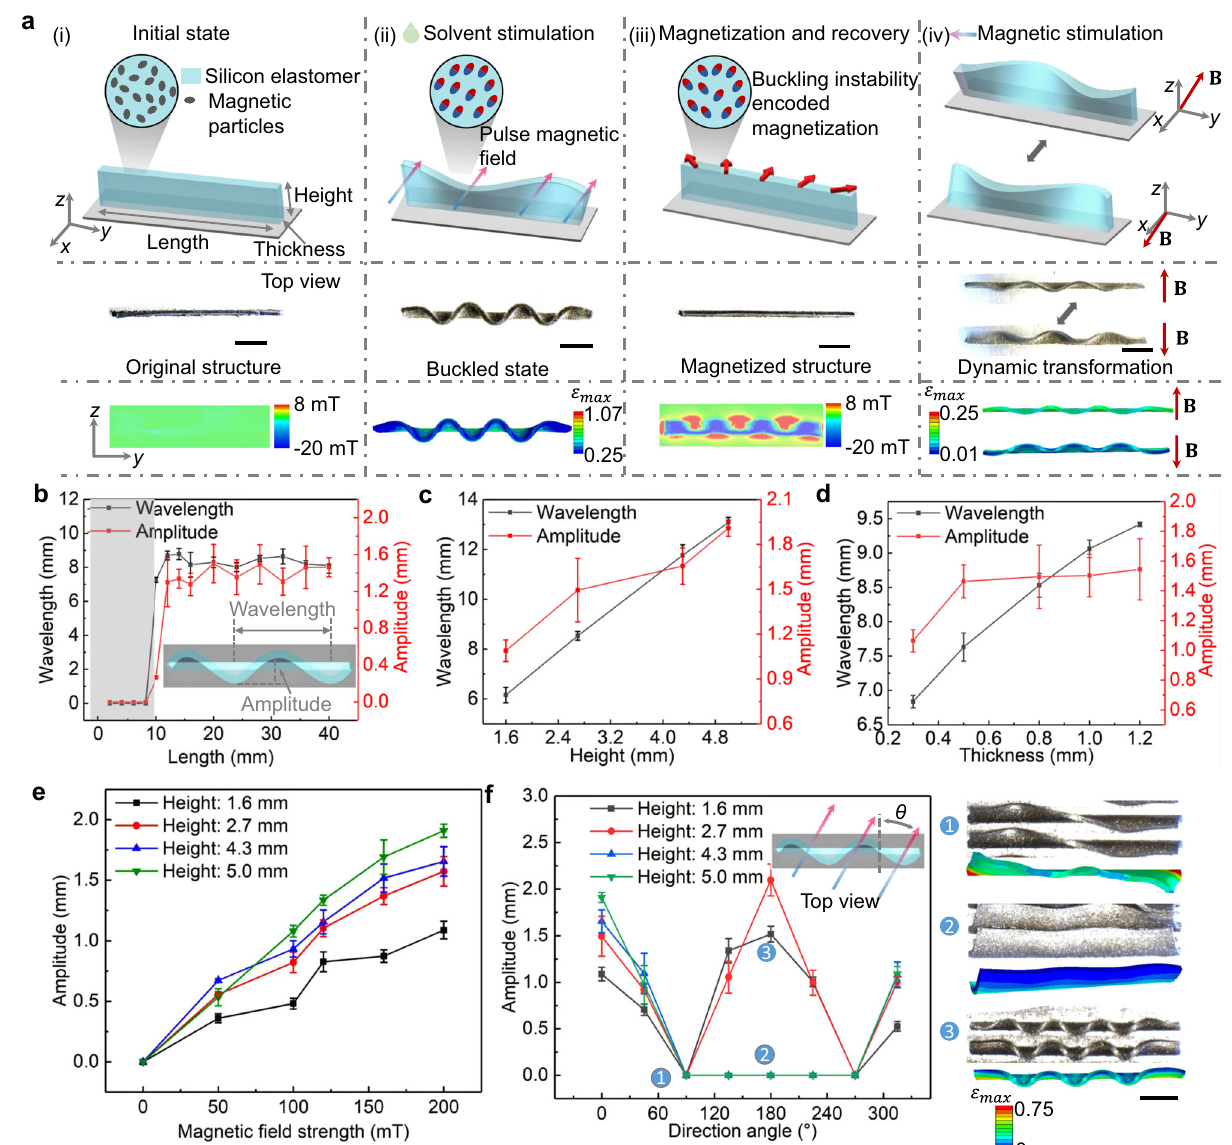
e – f Thequantitativerelationshipbetweenthemagnetic fi eldstrength( e ),direction angle ( θ ) of magnetic fi eld and amplitude of the buckling structure ( f ). The inset images illustrate experimentaland simulation results. The inset image with label ‘ 1 ’ shows twisted strip structures when the direction angle is equal to 90 ◦ . The inset imagewithlabel ‘ 2 ’ showscollapsedstripstructureswiththeheightof5.0mmwhen the direction angle is equal to 180 ◦ . The inset image with label ‘ 3 ’ shows the wavy patternsofstripstructureswiththethicknessesof1.6mmwhenthedirectionangle isequalto180 ◦ .Errorbarsstandforthestandarderrorofthemeanwiththenumber of trials n =3. ε max is the maximum principal strain. The scale bar is